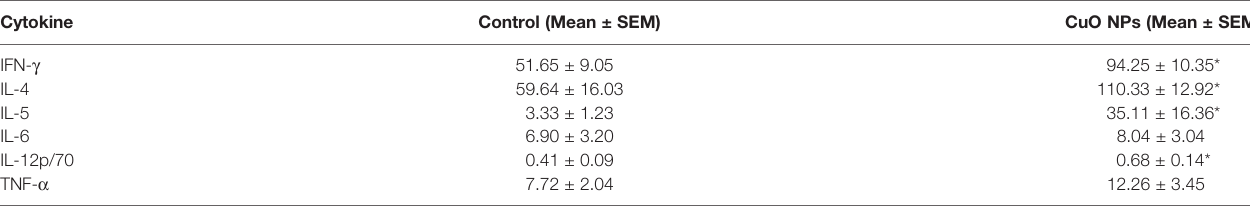
TABLE 2 | Concentrations of cytokines in spleen cell culture supernatants in mice after 6-week inhalation of CuO NPs. Cytokine Control (Mean ± SEM) IFN-